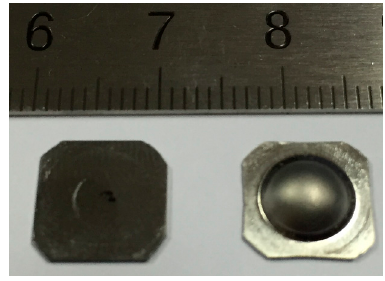
Figure 1. Specimen for hydraulic bulge test.